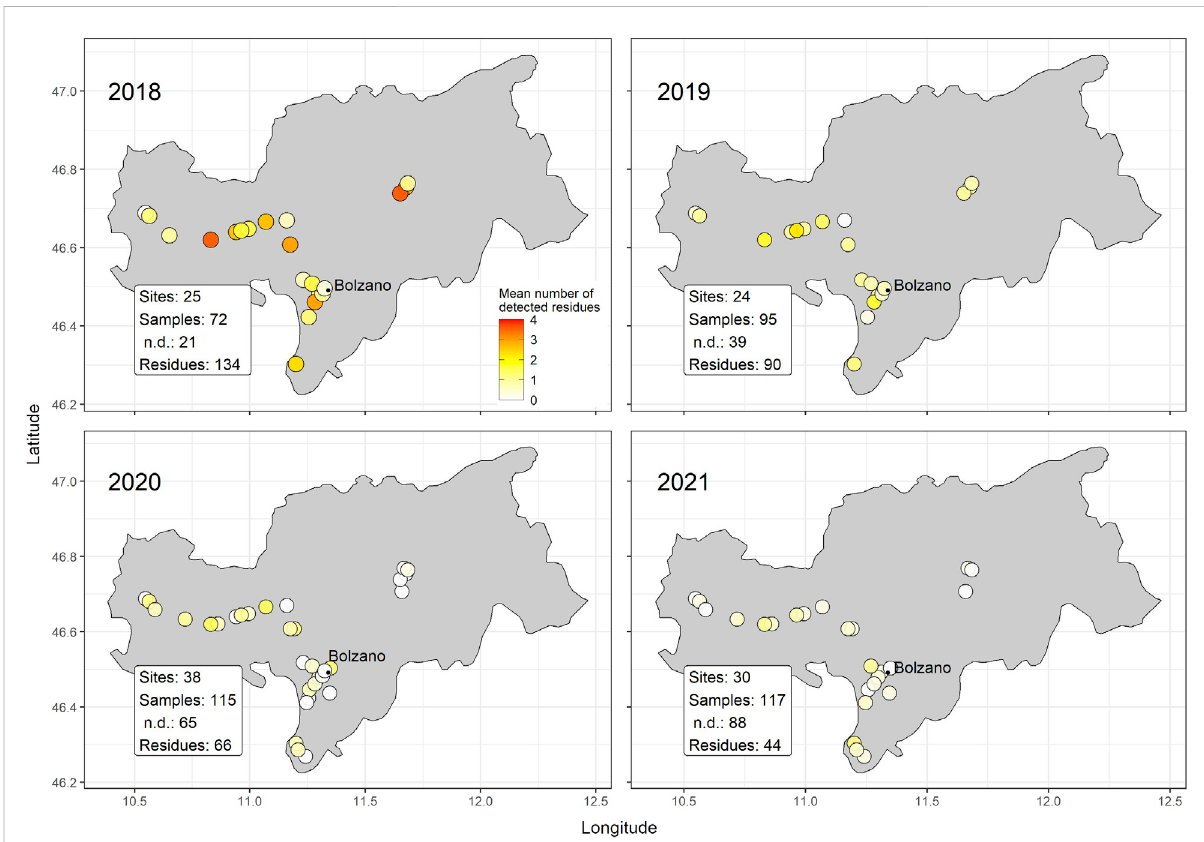
FIGURE 7 Spatio-temporal distribution of the mean number of detected residues per site from 2018 to 2021. The color code gives the mean number of detected residues (number of residues/sampling date) for all monitored sampling sites, ranging from no detection (white) to a maximum of 3.7 residues (red). The total number of taken samples and analyzed sampling sites varied between the years (see box). Information about the total number of detected residues per year and no detections (n.d.) per year is given in the box as